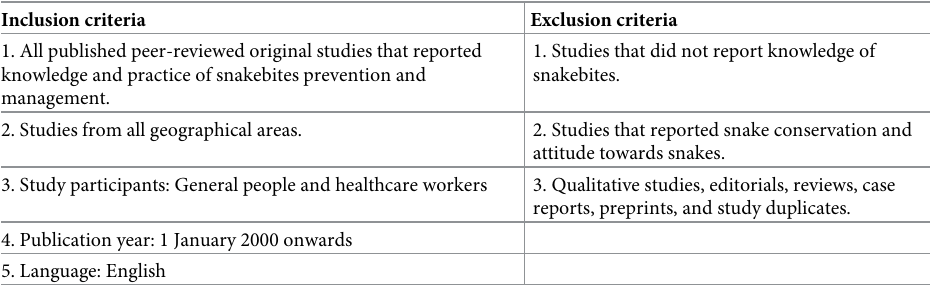
Table 1. Criteria for study inclusion and